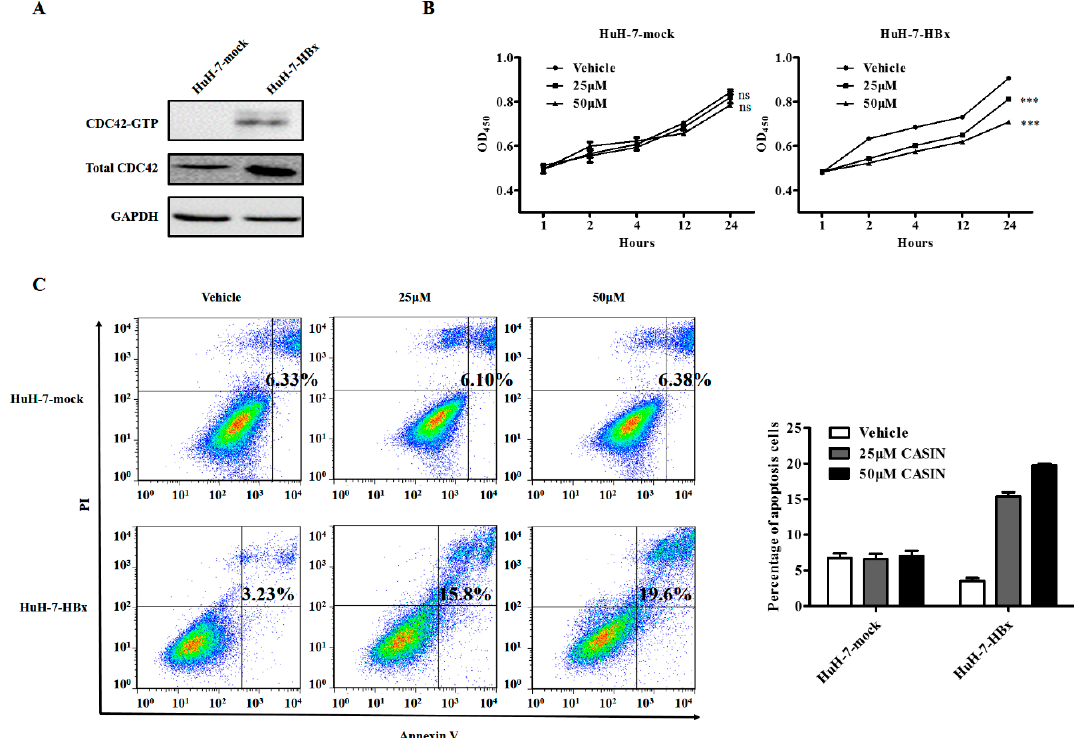
Figure 4. CDC42 inhibitor reduced proliferation and promoted apoptosis only in HBx-expressing HuH-7 cells. ( A ) Active CDC42 was detected by the pull-down assay using GST-PAK1-PBD beads in HuH-7-mock and HuH-7-HBx cells; ( B , C ) cell viability assay ( B ) and Cell apoptosis analysis ( C ) was conducted in HuH-7-mock and HuH-7-HBx cells cultured without or with treatment of different doses of CASIN, implying that HuH-7-HBx cells was more sensitive to CDC42 inhibition. *** p < 0.001. Data represent the mean ± SEM of two different experiments. ns, not significant.